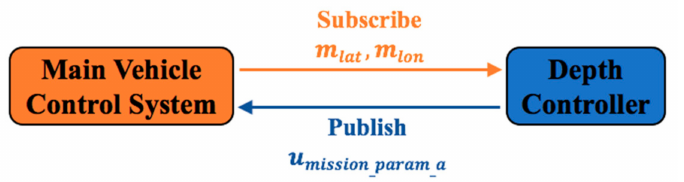
Figure 7. Exchange of data between the main vehicle control system and a depth controller when the glider changed its depth when a waypoint was reached.